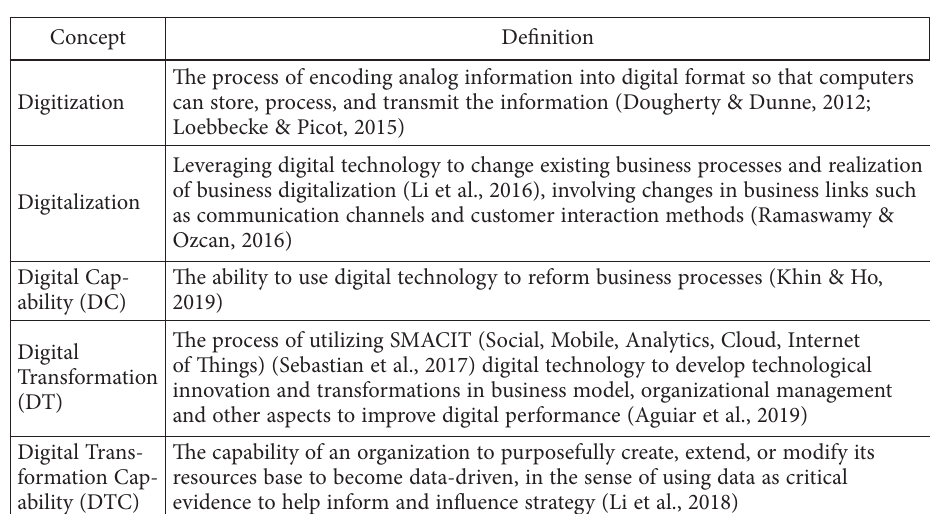
Table 1. Definitions of concepts related to digital transformation capability